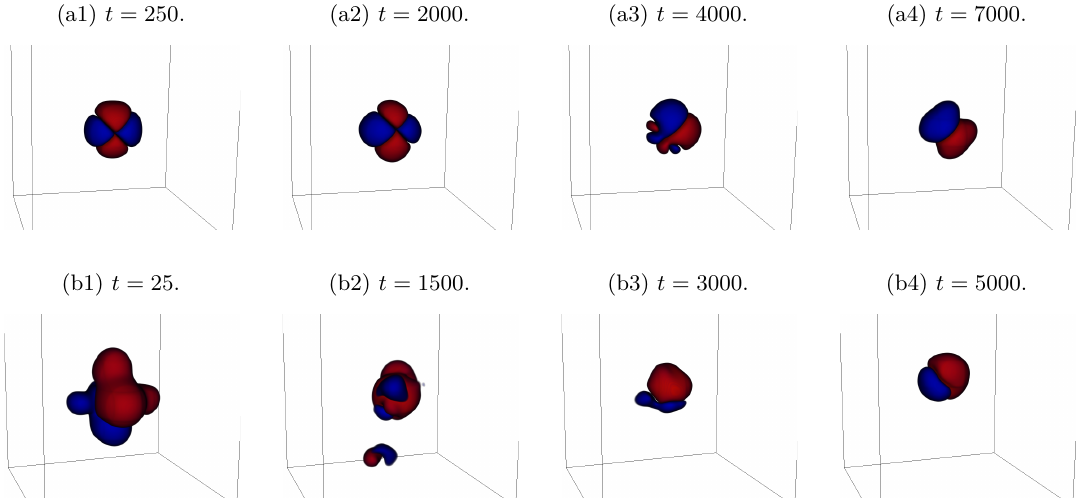
Figure 12 . Two evolution sequences of “transit CSQs” in 3+1D. These transit states continuously emit radiation and evolve to an unequal CSQ with only one positive and one negative charge lump. In the first row, 4 unequal charge lumps are initially placed at a distance of 2 . 0 from the center, with other parameters the same as those in the right plot of figure 11. In the second row, the initial configuration is prepared with 25 charge lumps, rather randomly